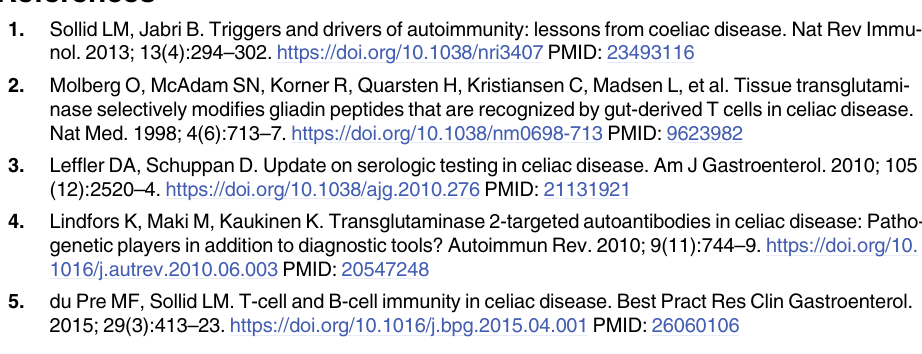
S1 Fig. Adequate separation of TG2-gluten monomers and multimers as evaluated by SDS PAGE. Proteins were allowed to self-crosslink as previously described, then separated by size- exclusion chromatography before running on a gel. Leftmost lane: protein ladder, numbers indicate molecular weight. kD: kilodaltons. 1: TG2- α 33merEEE control (not crosslinked/sepa- rated). 2: TG2- α 33merEEE monomers. 3: TG2- α 33merEEE multimers. 4: TG2 control (not crosslinked/separated). 5: TG2- α 33mer monomers. 6: TG2- α 33mer